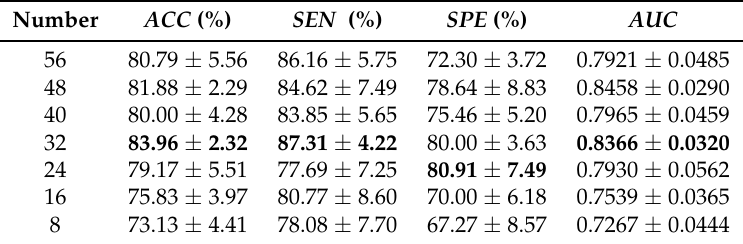
Table 8. Classification performance of 2D models with different numbers of 2D slices for T1 task.